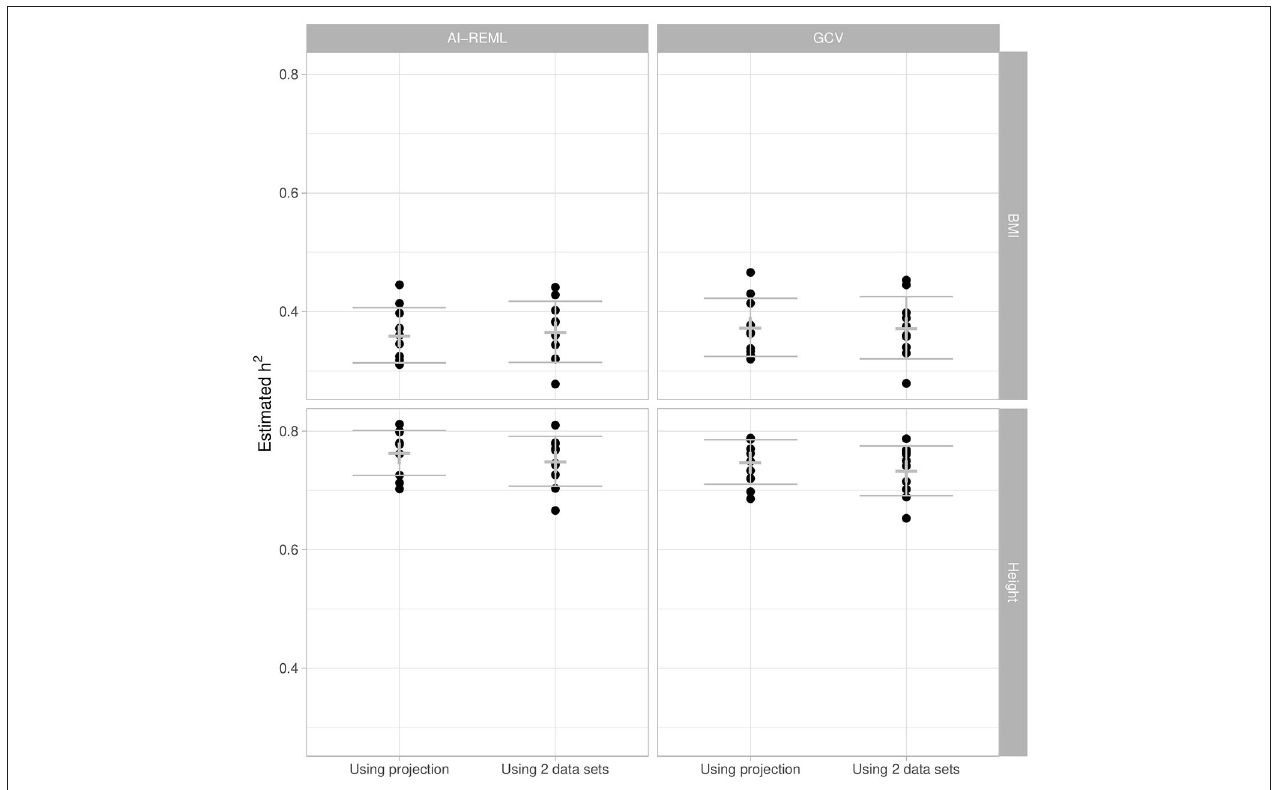
FIGURE 5 | Heritability estimation of BMI and height using AI-REML and GCV, with the projection-based approach and with the two-set approach. We sub-sampled the original UK Biobank dataset 10 times for replication. The cross corresponds to the mean and the error bar to the mean ± one standard deviation.